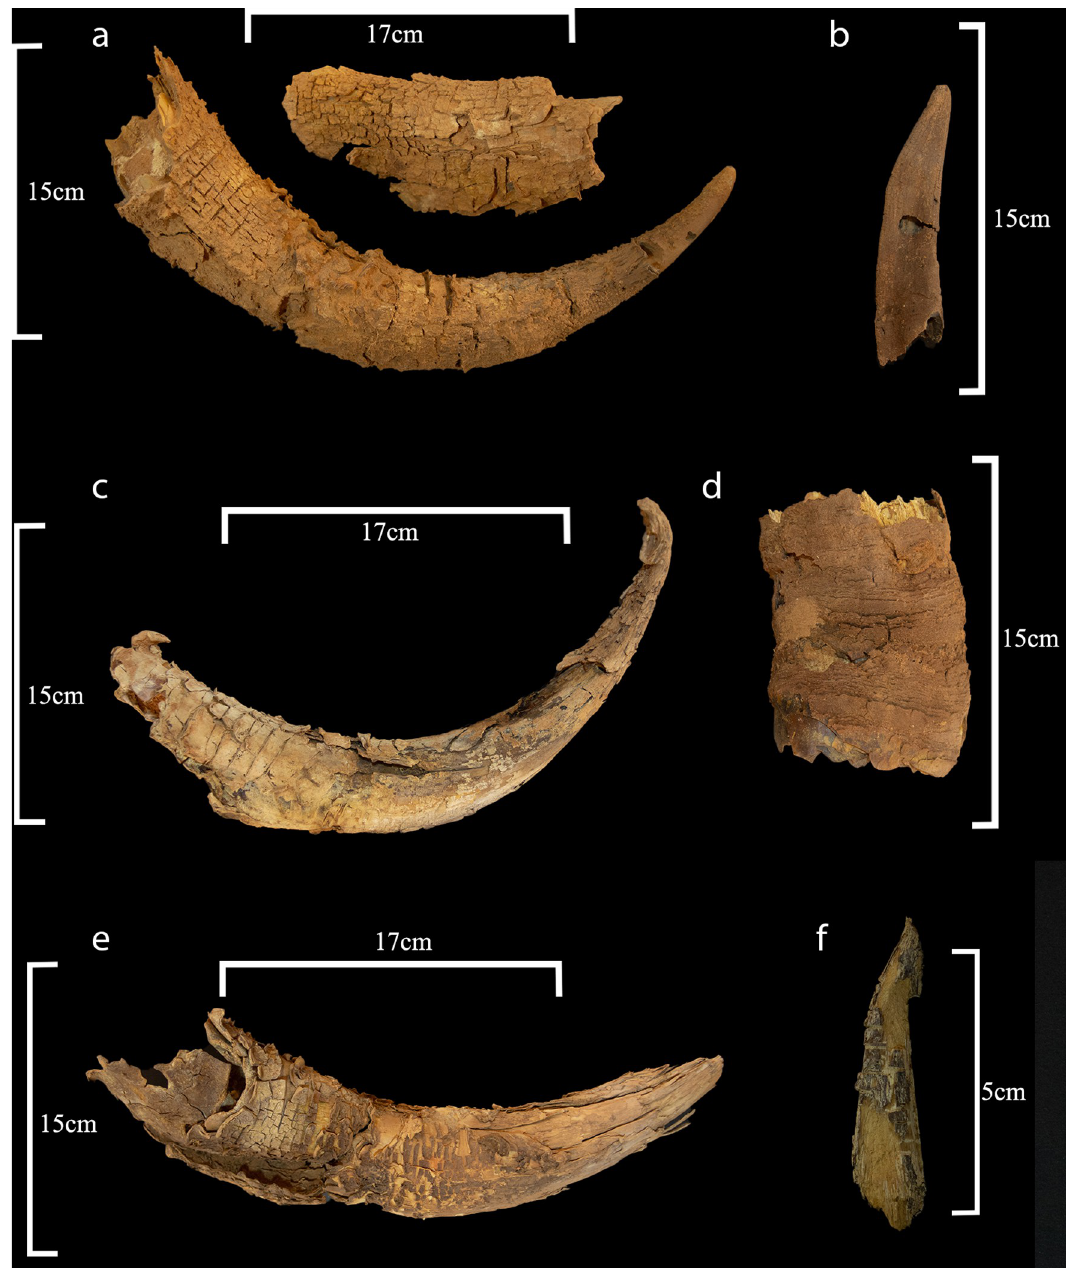
Fig 16. Horns recovered from mustatil IDIHA-F-0011081 –a: Cattle horn (#0043). b: Goat horn (#0036); c: Cattle horn (#0034). d. Cattle horn (#0040). e. Bos sp. horn (#0032). f. Gazelle horn (#044). Sex determination is based on horn basal measurements [27, 31]. Considering basal circumfer- ences (210-240mm) and diameters (maximum diameters 70–86.6mm; minimum diameters 62–63.5mm), four cattle specimens (#0033, #0037, #0039 –SANU-66606 and #0043) and two Bos sp. (#0048 and #0082) have an oval cross-section and fit male metrical ranges (Table 2) [10, 27, 28, 32]. #0032 Bos sp. sheath is also a male, if domestic. Based on petrous bones an MNI of three domesticates is recorded.